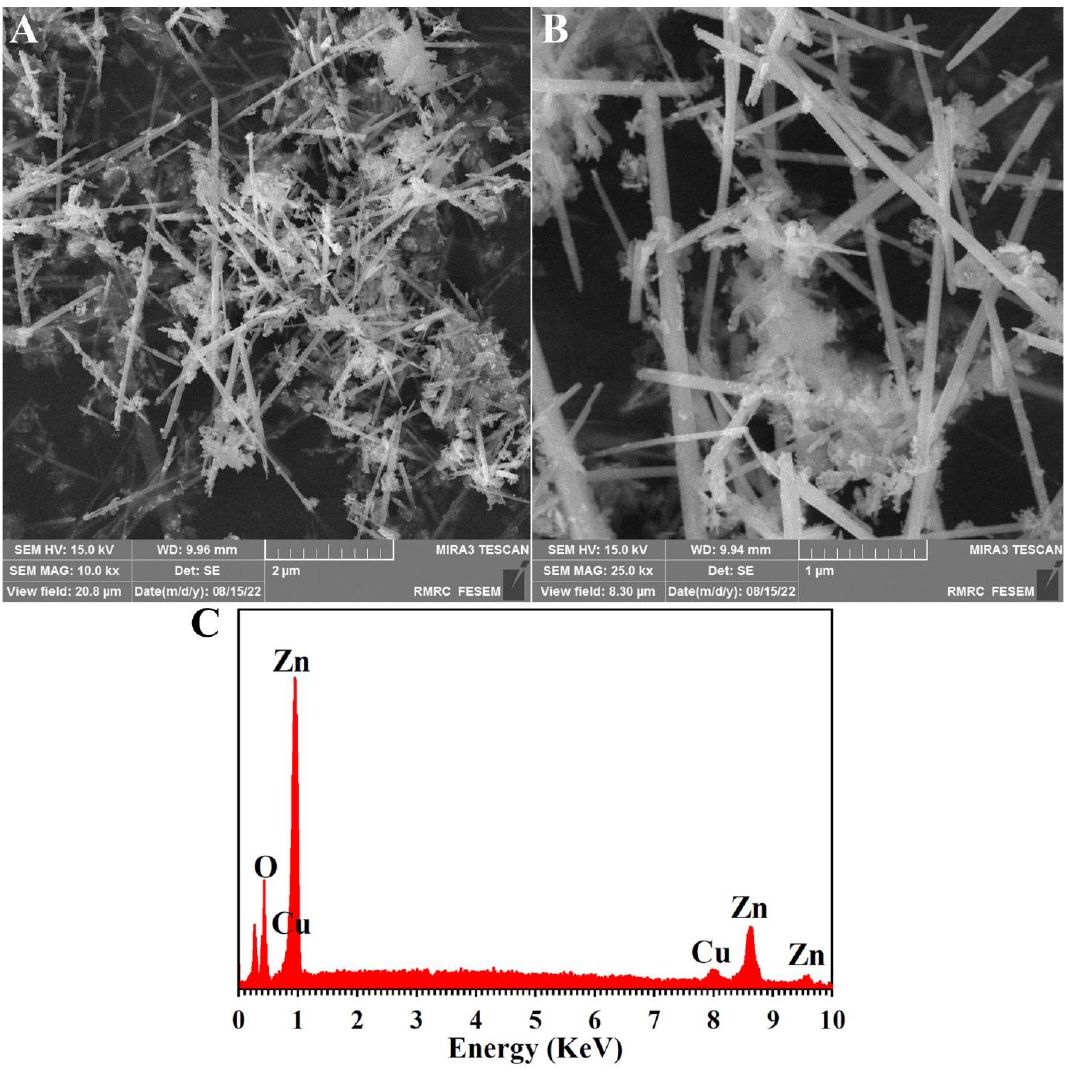
Fig. 2. FE-SEM image (A and B) and EDS spectrum (C) of ZnO-40Cu2O